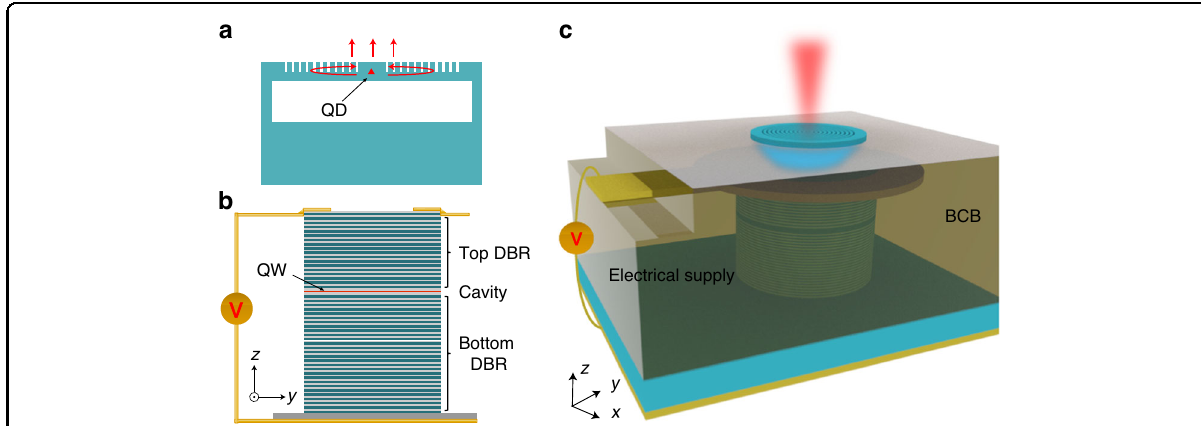
Fig. 1 Illustration of the hybrid integrated SPS. a CBG with a single QD embedded for bright single-photon emissions. The single photons emitted from the QD are con fi ned in the suspended membrane by total internal re fl ections, partially re fl ected to the center of the CBG and partially scattered to the top by second-order Bragg gratings consisting of shallowly etched air trenches. b Micropillars with embedded quantum wells for electrically-injected microlasers. c Illustration of the hybrid integrated device. Pumped by the on-chip micropillar laser with electrical injections, the QD in the CBG emits highly-directional single photons to the free